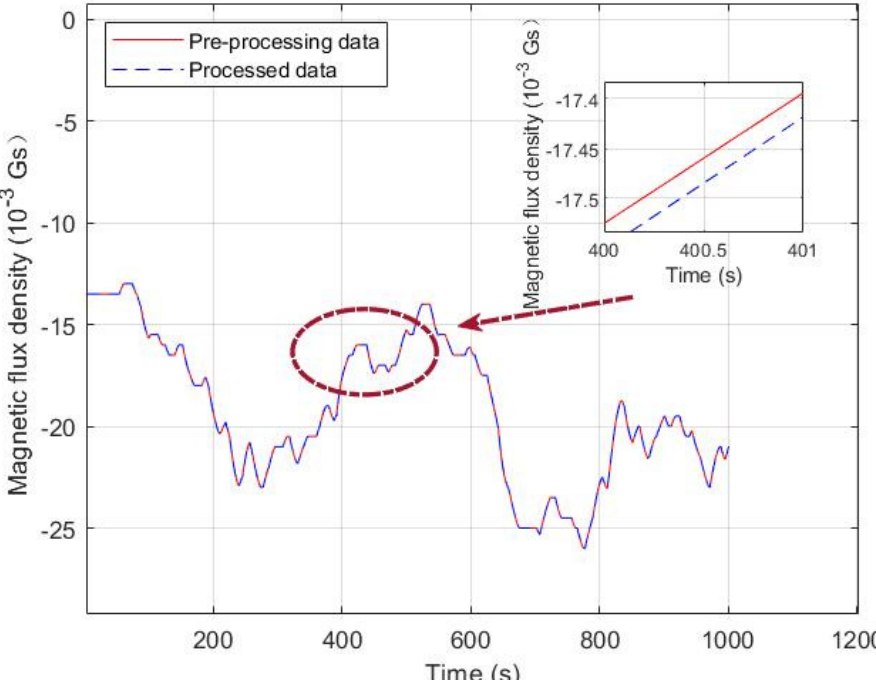
Figure 3. Processing of sampled data (magnetometer).